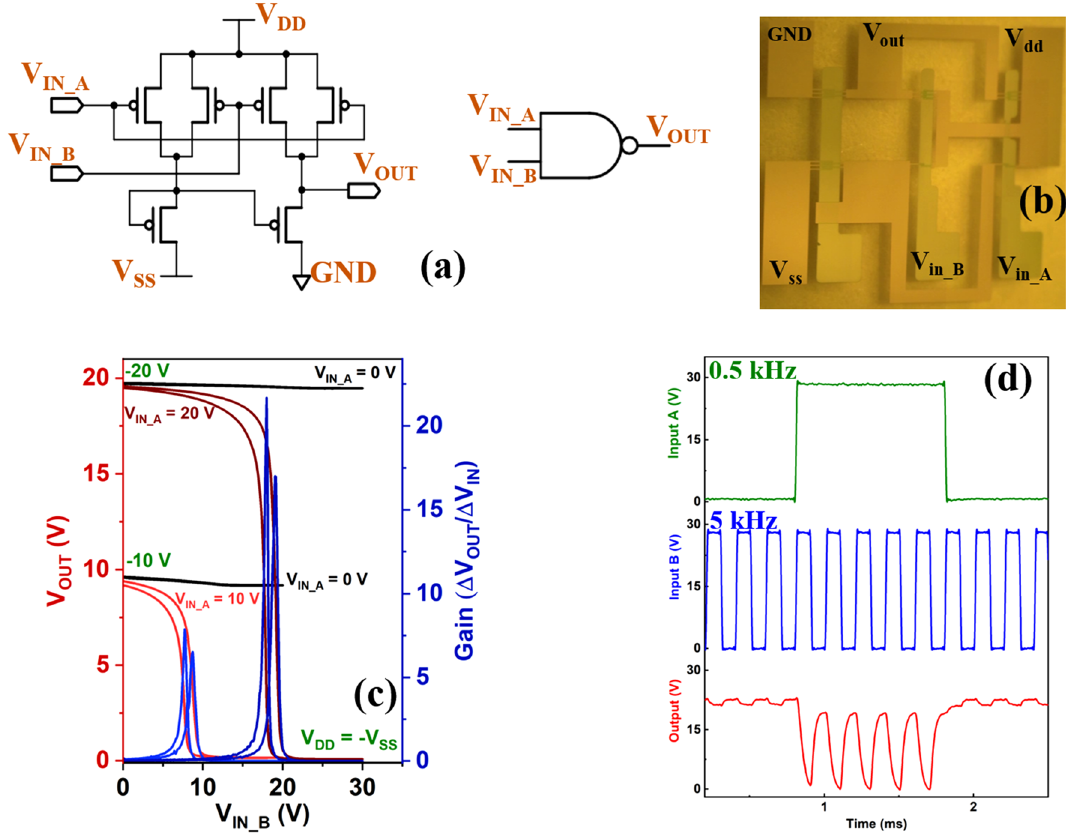
Figure 7. NAND logic circuit design and characteristics. ( a ) Circuit schematic of NAND device with zero- V GS -load p-type pseudo-CMOS design. ( b ) Photograph of fabricated NAND circuit. ( c ) Measured output voltage (V OUT ) and small-signal gain as a function of input voltage B (V IN_B ) for input voltage A V IN_A = 0 V and V IN_A = 10 V when V DD = − 10 V and V IN_A = 20 V when V DD = − 20 V. ( d ) Dynamic response of NAND logic circuit with input signals of frequencies, V IN_A = 0.5 kHz and V IN_A = 5